Question: Condense the content of this figure into a single sentence.
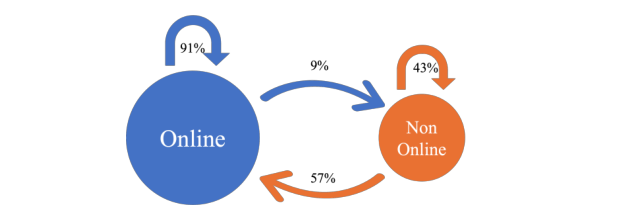
Answer: Change in online vs non-online information sources before and after browsing online.